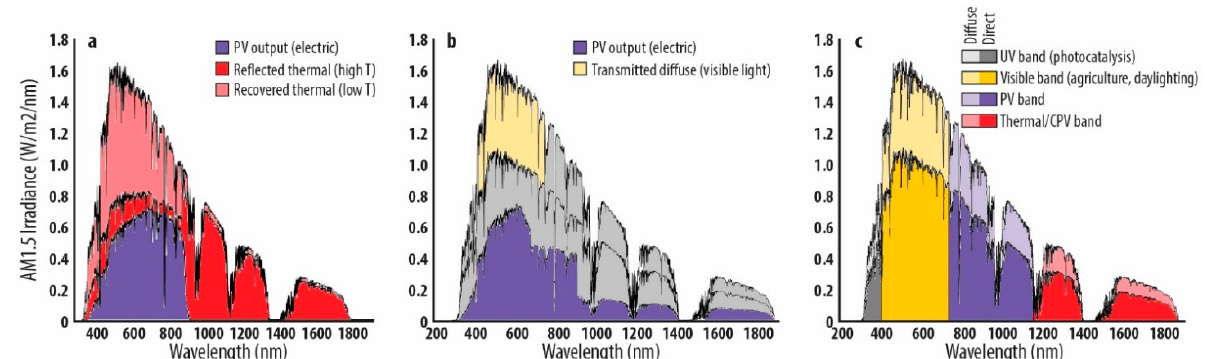
Figure 1. Solar resource splitting examples: ( a ) Dividing the solar resource between electricity, low-temperature heat and high-temperature heat using an optical concentrator including a silicon solar cell, a heat recovery system, a spectrum- splitting filter and a high-temperature thermal absorber; ( b ) Dividing solar energy between light & electricity using a refractive concentrator; ( c ) “range of possibilities” for resource splitting, including UV for chemical/catalytic processes, visible band for agriculture & daylighting, visible + short NIR for Si solar cells, all wavelengths for thermal applications, with distinction between direct (can be concentrated) and diffuse (minimal or no concentration).